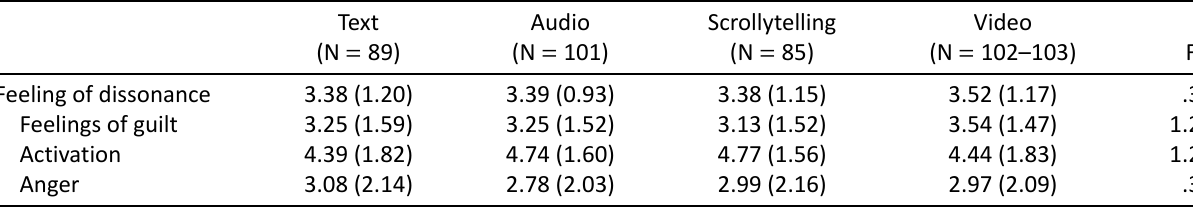
Table 5. Feeling of dissonance and its factors.